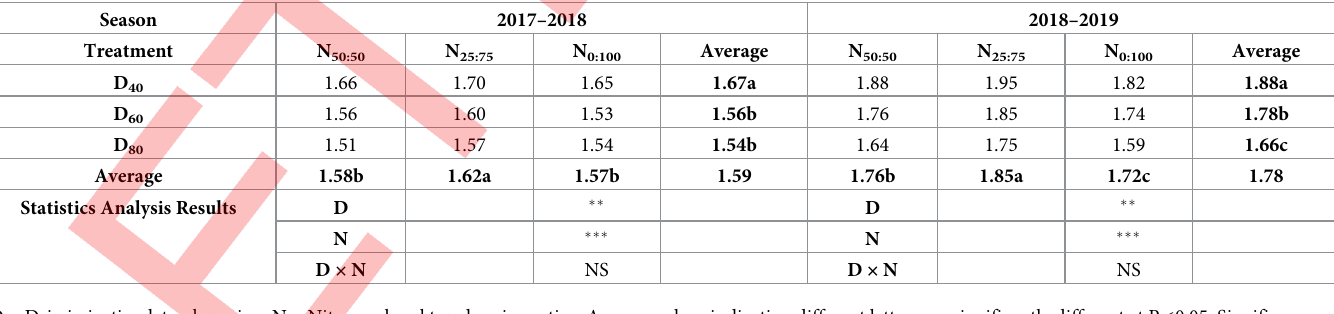
Table 6. Statistics analysis results of WUE (kg m -3 ) of winter wheat during 2017–2018 and 2018–2019 growing season. Season Treatment